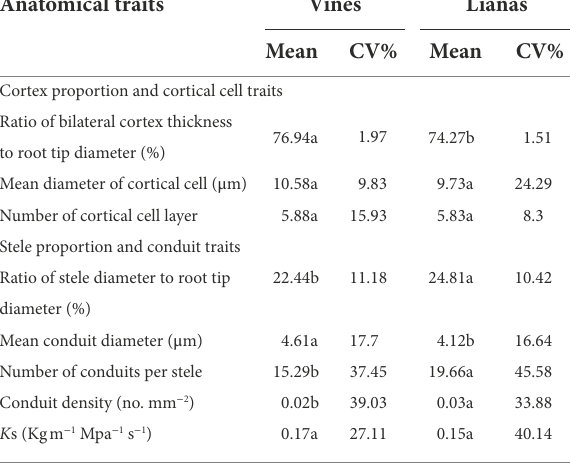
TABLE 1 Mean values and coefficient of variations of cortex and stele proportions, and cortical cell and conduit traits of root tips in vine